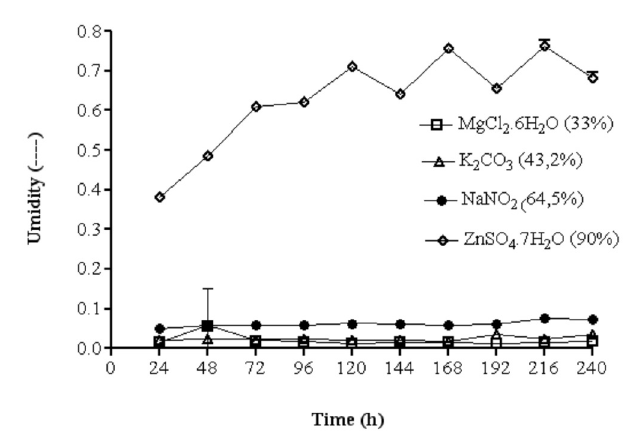
FIGURE 5 - Moisture uptake of the spray-dried extract from feverfew (humidity as a function of time).